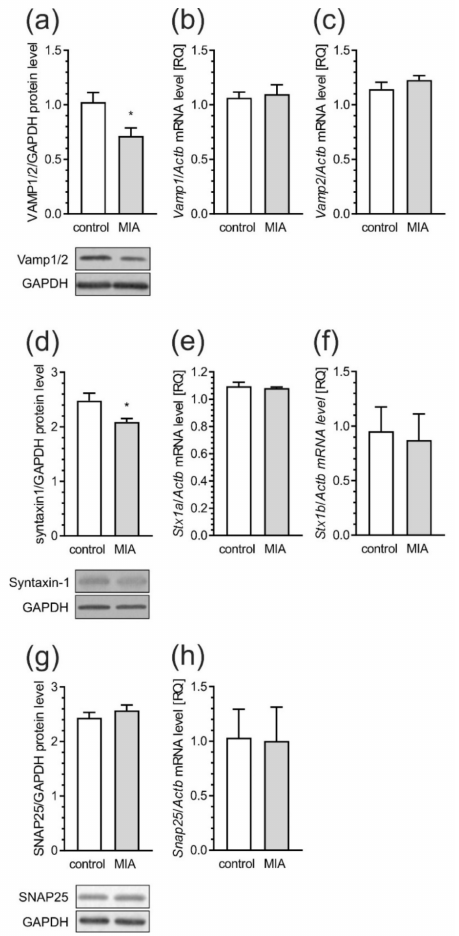
Figure 10. MIA a ff ects the levels of SNARE complex components in the brain of o ff spring rat. E ff ects of MIA on synaptic proteins SNARE complex in the cerebral cortex of rat o ff spring. O ff spring male rats at PND 53–54 were sacrificed and brain tissues were collected. Immunoreactivities of synaptobrevin (VAMP1 / 2) ( a ), syntaxin-1 ( d ) and SNAP25 ( g ) normalized to GAPDH were analyzed by SDS-PAGE and Western blot. The mRNA levels of Vamp1 ( b ) and Vamp2 ( c ) of Stx1a ( e ) and Stx1b ( f ), and Snap25 ( h ) were determined using real-time PCR and normalized to Actb ( β -actin). Representative Western blots are presented. Results of densitometric analysis of the investigated proteins and gene expressions are presented as the mean value ± S.E.M. (a–n = 9–10, b–n = 3–5, c–n = 3–5, d–n = 6–7, e–n = 3–5, f–n = 3–5, g–n = 8–9, h–n = 3–5). Data were analyzed using Student’s t -test. * p < 0.05, compared to control